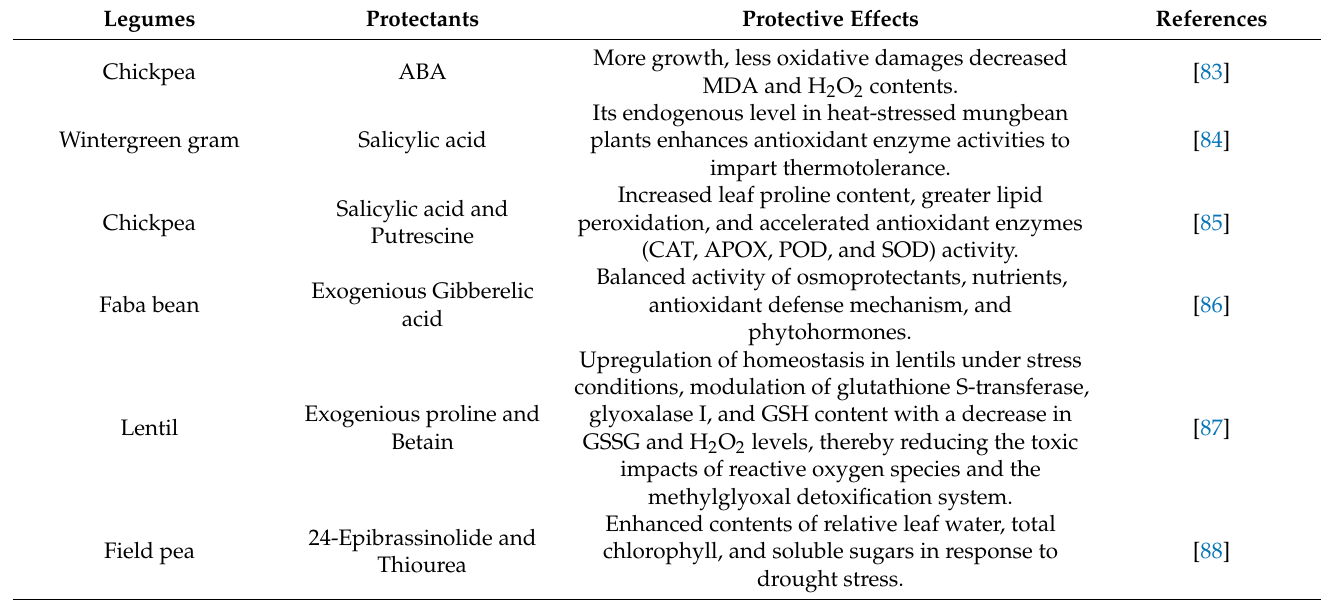
Table 4. Protective effects of plant growth regulators in cool-season food